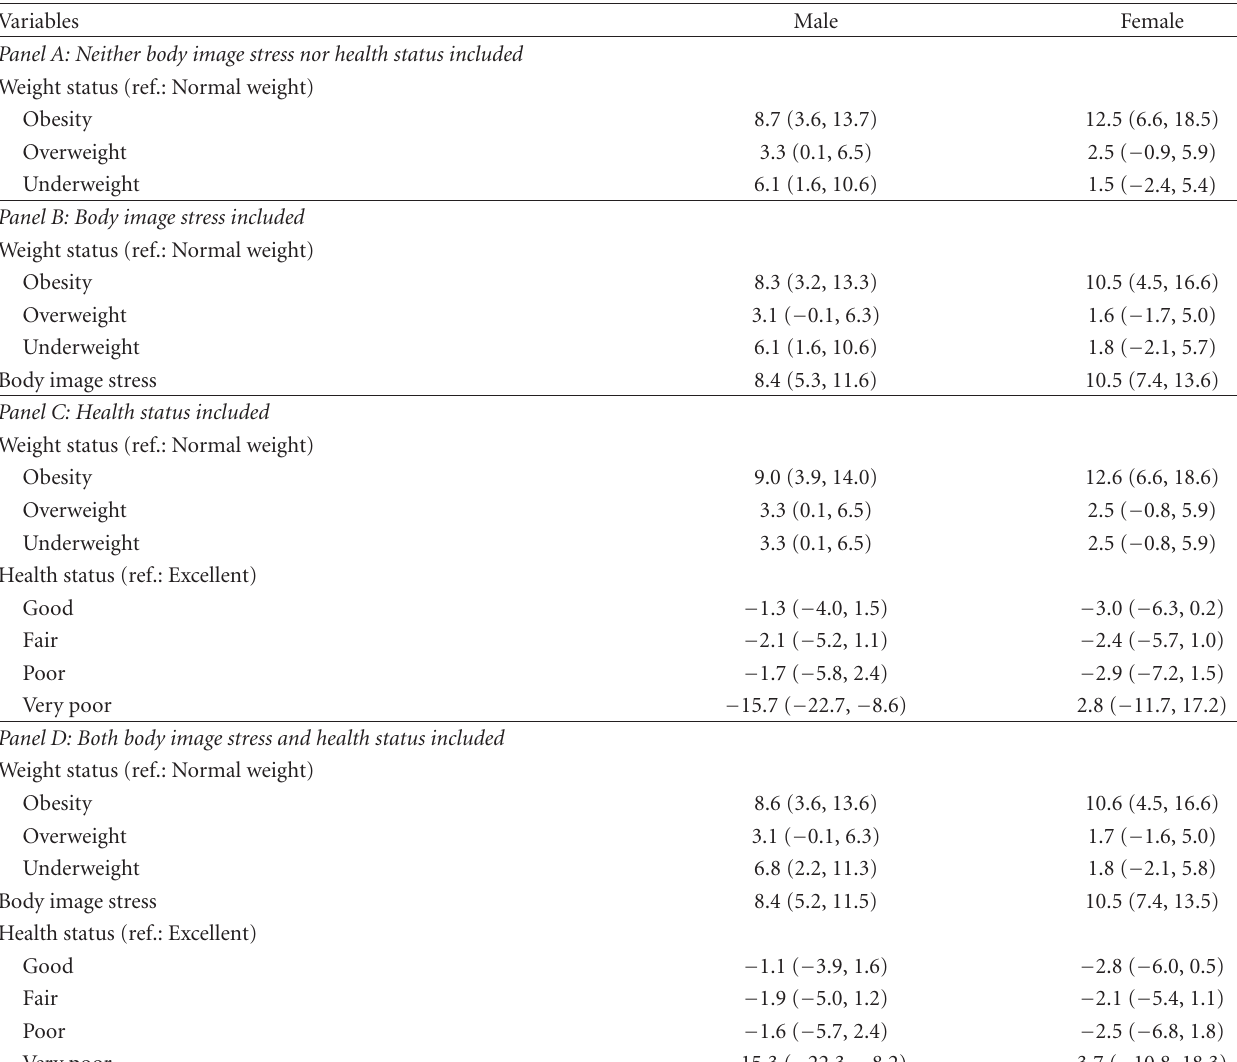
Table 4: Marginal probabilities (in percentage points) of being enrolled in vocational high school (versus general high school) among first-year high school